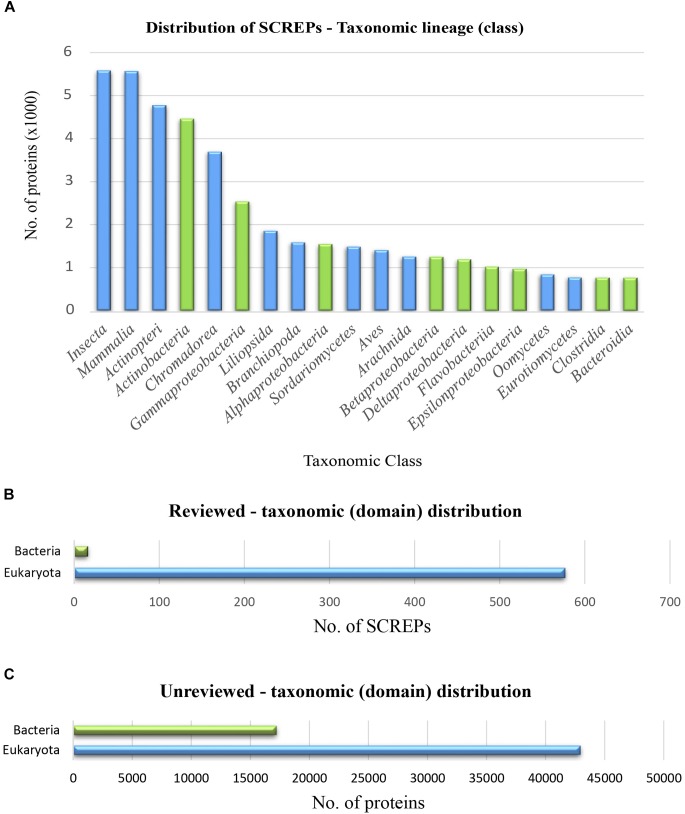
Taxonomic distribution of SCREPs. (A) Distribution of the 20 highest occurring taxonomic classes of SCREPs, blue indicating eukaryotic members and green indicating bacterial. (B) The total frequency of reviewed SCREPs within their respective taxonomic domains. (C) The total frequency of unreviewed SCREPs within their respective taxonomic domains.